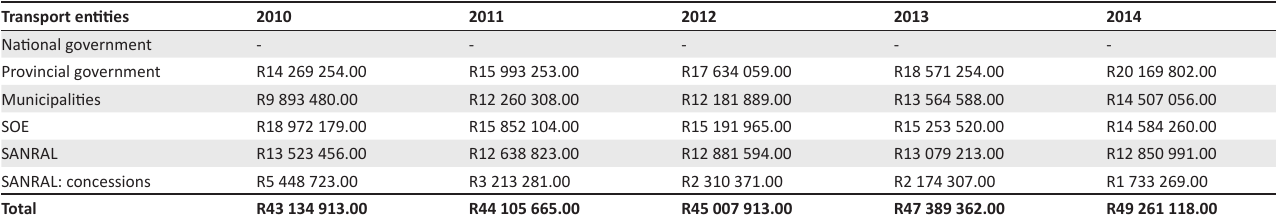
TABLE 3: Road expenditure (’000).